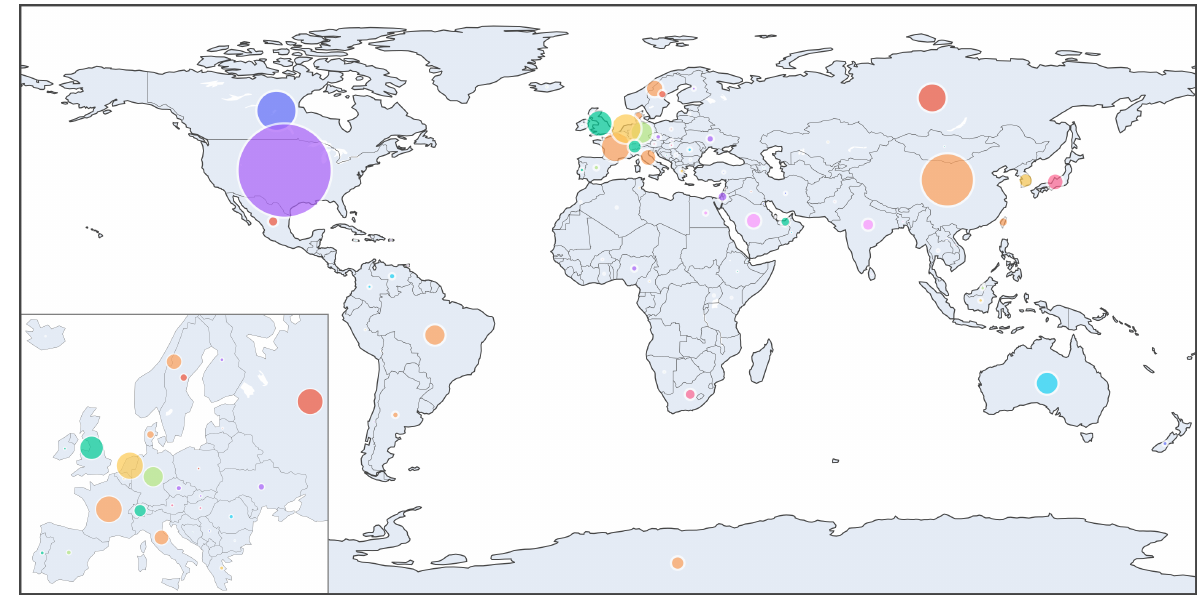
Figure 2. The last 38-years of academic publications by country. Europe is in the zoomed inset in the lower-left corner. The circle on Antarctica represents erroneous affiliations and serves as an error indicator.